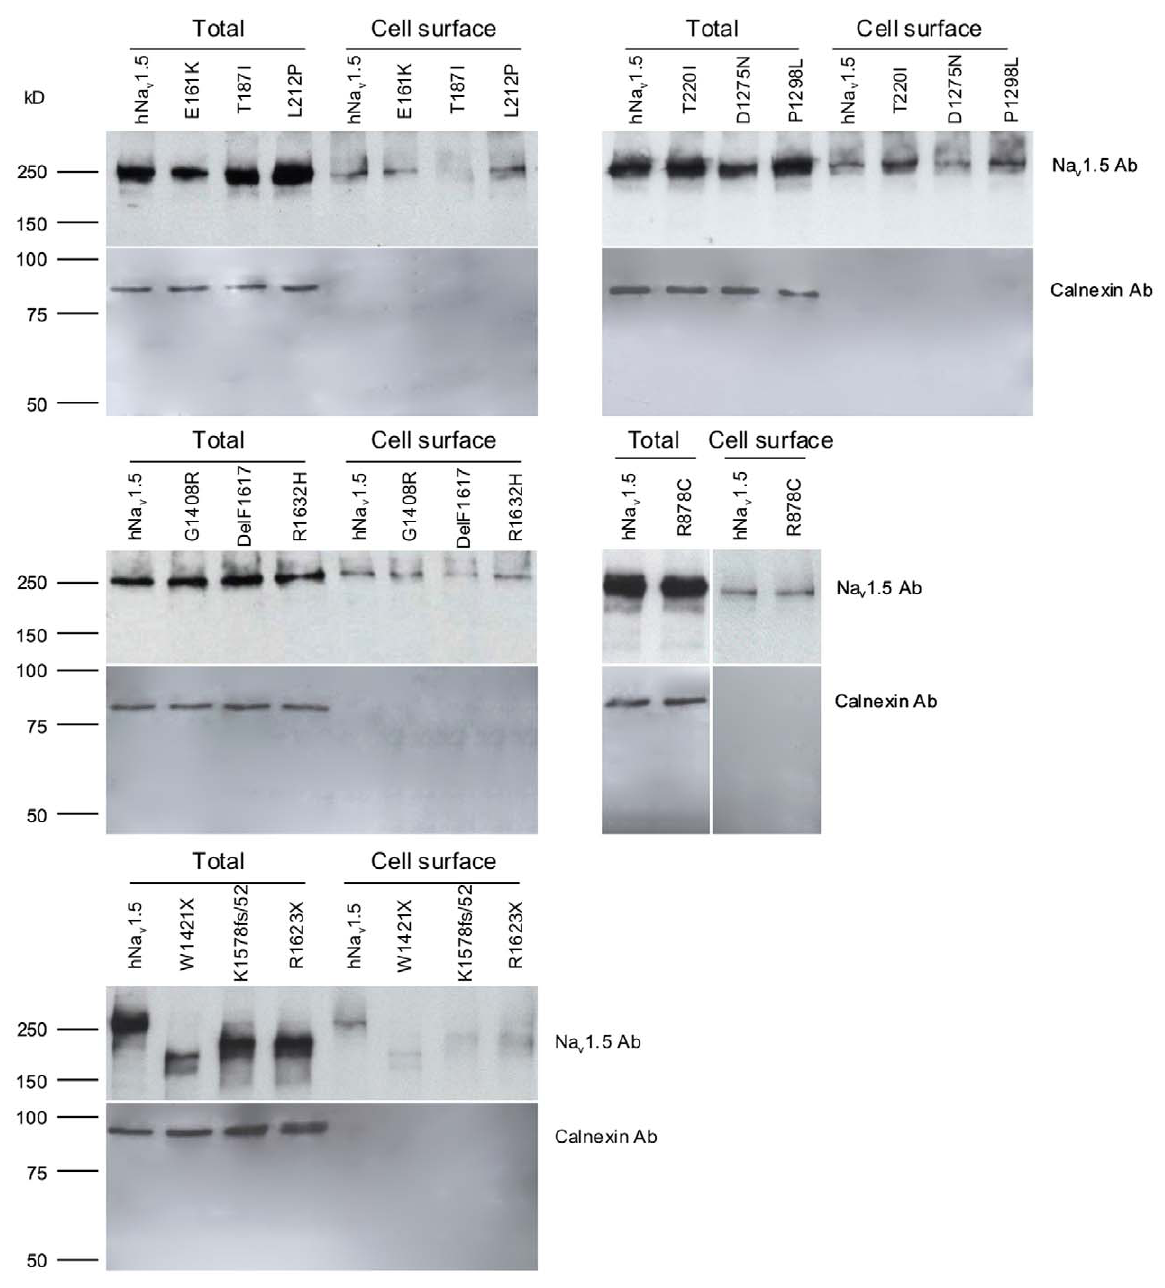
Figure 5. Representative Western blots showing Na v 1.5 polypeptides purified from the surface of HEK293 cells by the biotinylation/precipitation procedure (cell surface) and the Na v 1.5 polypeptides in HEK293 cell lysates (total). Calnexin was used as a control to demonstrate the absence of endoplasmic reticulum membranes in the isolated plasma membrane fraction. doi:10.1371/journal.pone.0010985.g005 (Figs. 5 and 6). In a previous study on T187I, functional expression reduction of the cell surface biotinylation signal was much less could neither be restored by mexiletine treatment nor by co- pronounced than the reduction of the whole-cell current (Fig. 5), expression of the b 1 subunit [31]. A screen for known protein motifs suggesting impaired single channel properties even for correctly in the affected S2–S3 linker in domain I was unsuccessful. We noticed targeted mutant channels. that the distal half of this linker that included threonine 187 is highly conserved among voltage-gated Na + channels. It is possible that this linker region, which is located intracellularly, contains an unknown ER export signal. Fourth, loss-of-function can also be attributed to both a partial trafficking defect and alterations of channel kinetics, as observed for E161K and D1275N (Tables 1 and 2). For E161K, the densities or trafficking properties are less helpful when explaining